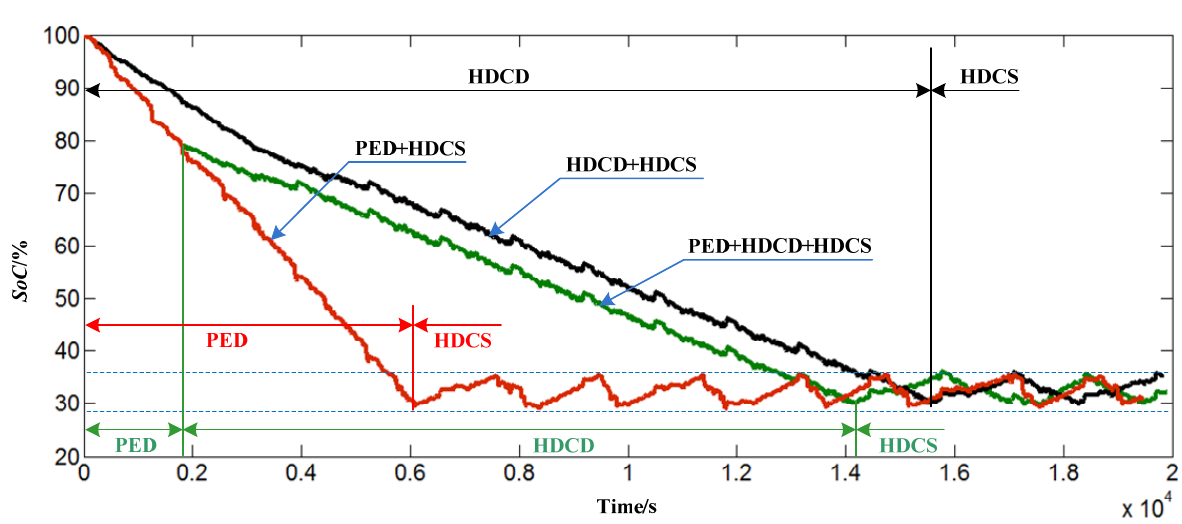
Figure 12. The battery SoC profiles under different